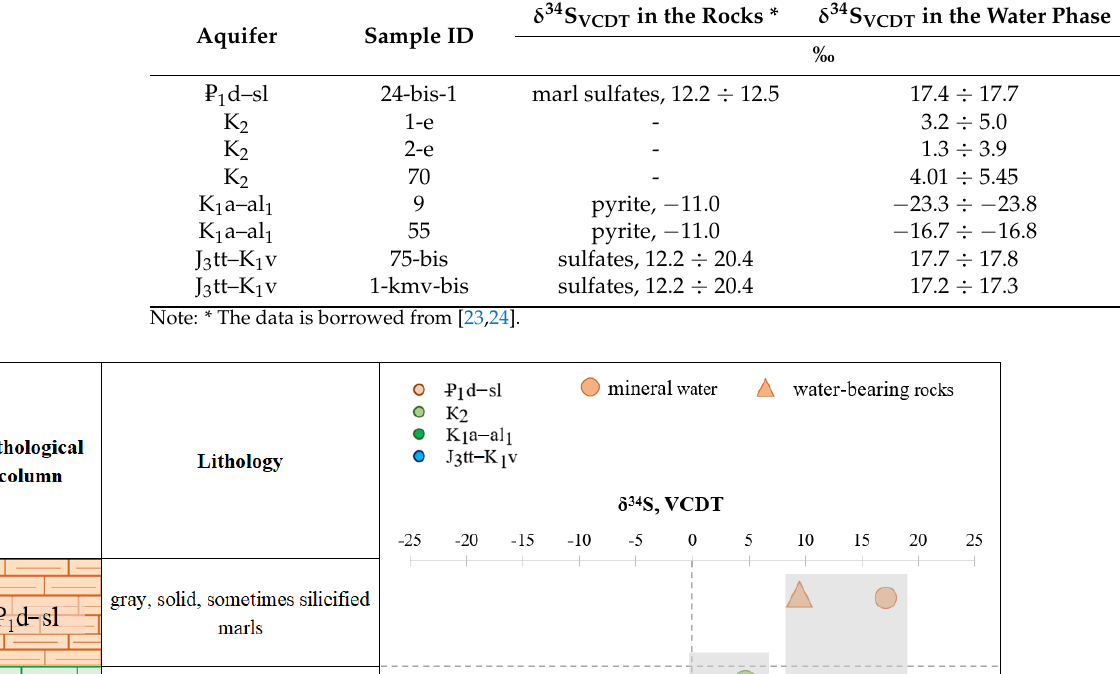
Table 7. Isotopic composition of sulfur in natural mineral water and water-bearing rocks of the Essentuki field.